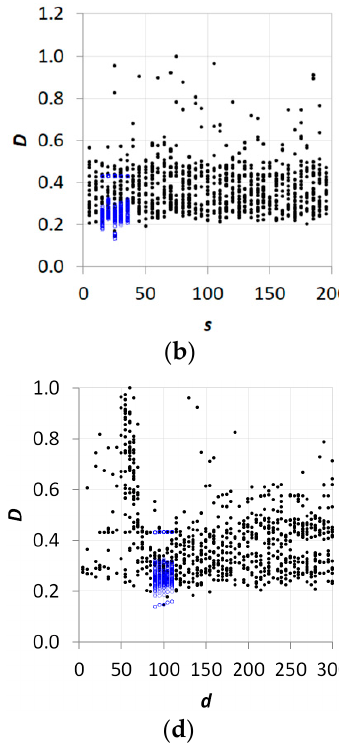
Figure 5. Segmentation parameters optimized on reference areas in the arid period (black dots represent values resulting from the rough; blue dots represent values resulting from the fine-tuning): ( a ) D versus k ; ( b ) D versus p ; ( c ) D versus s; ( d ) D versus d , dispersions.